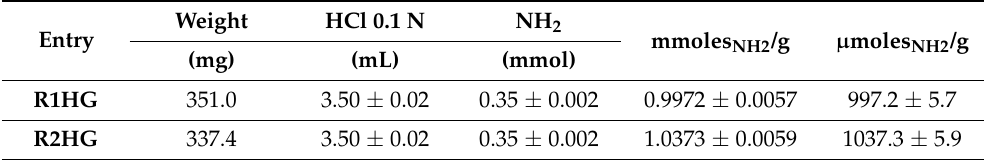
Table 3. Equivalents of NH 2 contained in R1HG and R2HG by potentiometric titration of an exactly weighted amount of gel.